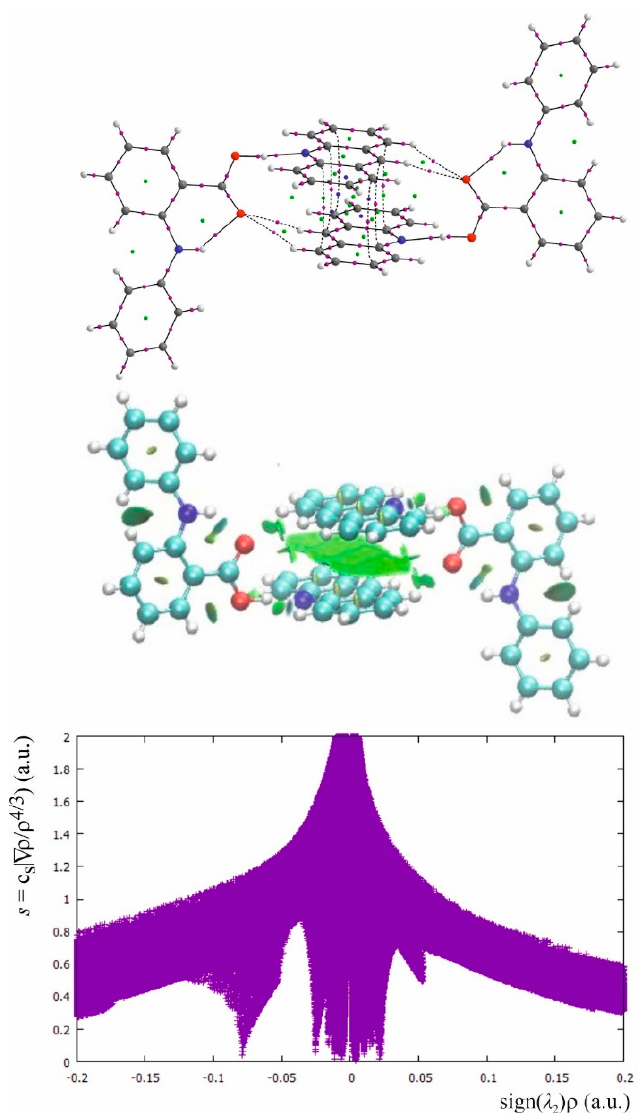
Figure 5. The QTAIM and NCI diagram, and NCI plot for fenamic acid–acridine complex common also for the complexes of mefenamic and tolfenamic acid.